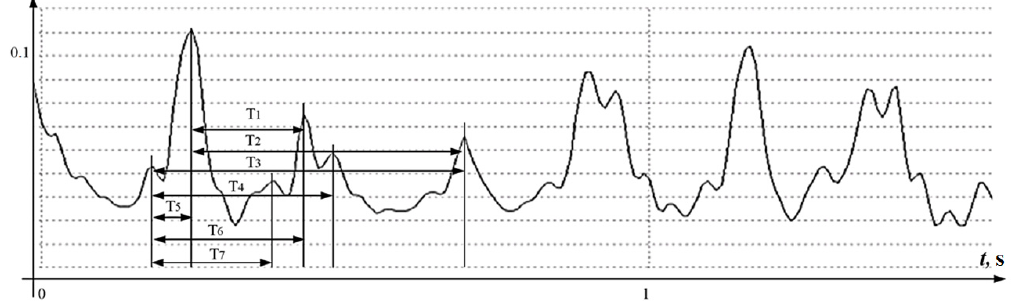
Figure 2. An example of a signal obtained after processing the reflected ultrasonic signal. T 1 –T 7 Intervals between signal peaks.